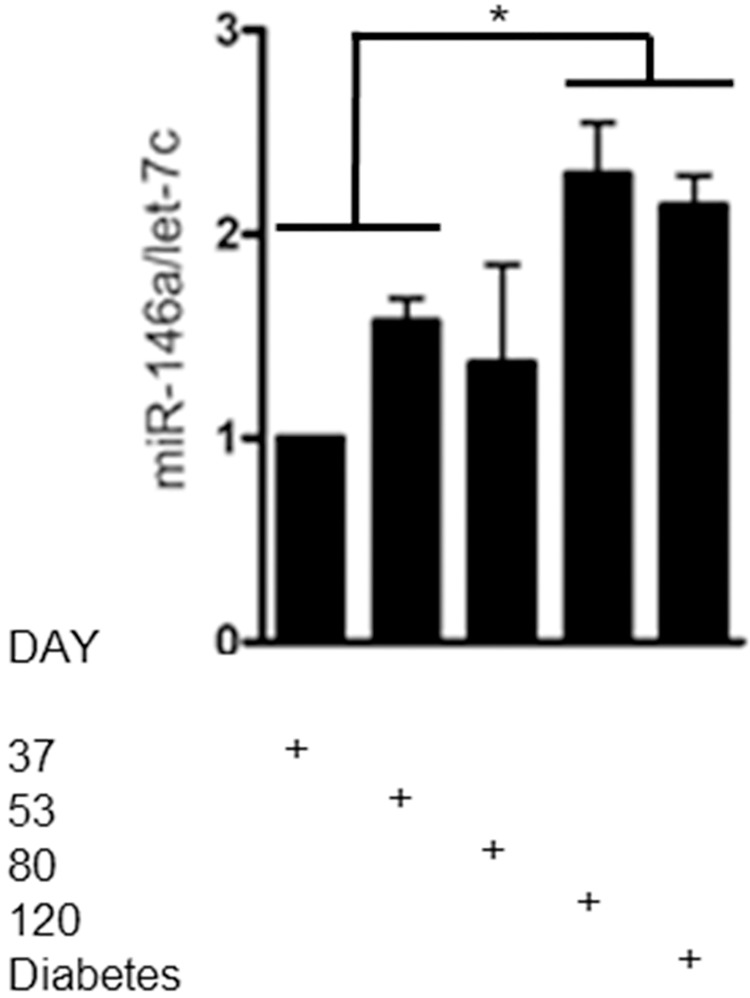
miR-146a-5p expression in the BB-DP rat T1D animal model.The expressions of miR-146a-5p and the internal control let-7c were analyzed by qRT-PCR on whole pancreas RNA from rats sacrificed at day 37, 53, 80, 120 or at diabetes onset (n = 3–6 in each group). Mean ± SD of data plotted as fold change compared to day 37. *p<0.05.